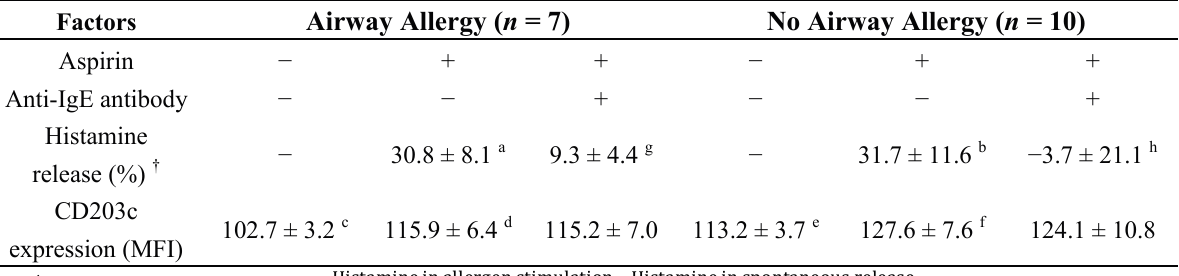
Table 4. Differences in basophil activation activity in sera between subjects with AICU with and without airway